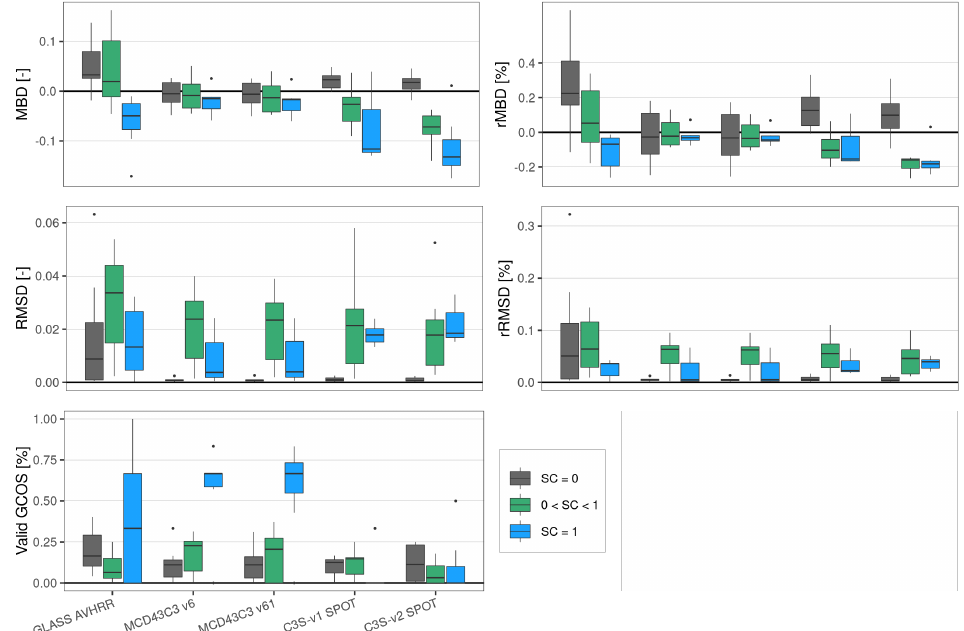
Figure 7. Variation of the absolute (MBD) and relative (rMBD) mean bias deviation, absolute (RMSD) and relative (rRMSD) root mean squared deviation, and percentage of points within the GCOS uncertainty requirements (Valid GCOS) with the levels of snow cover ( SC ) level from 2000/02 to 2014/05. Metrics are calculated with the stations covered by all the products (Ru-Cok, Ru-Che, US-Ivo, FPE, SXF, BOU, BOX). Each bopxlot point represents one